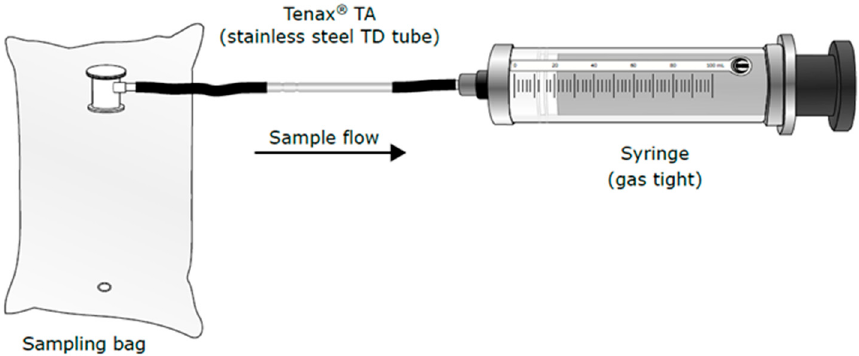
Figure 1. Sampling method 1 — syringe method.